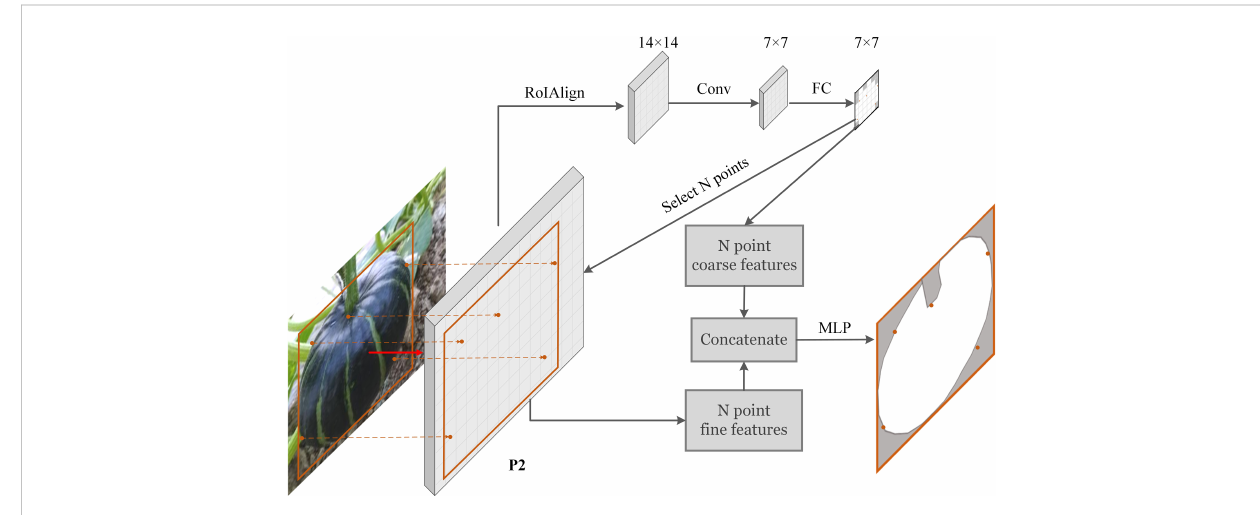
FIGURE 7 Scheme of point rendering mask head.